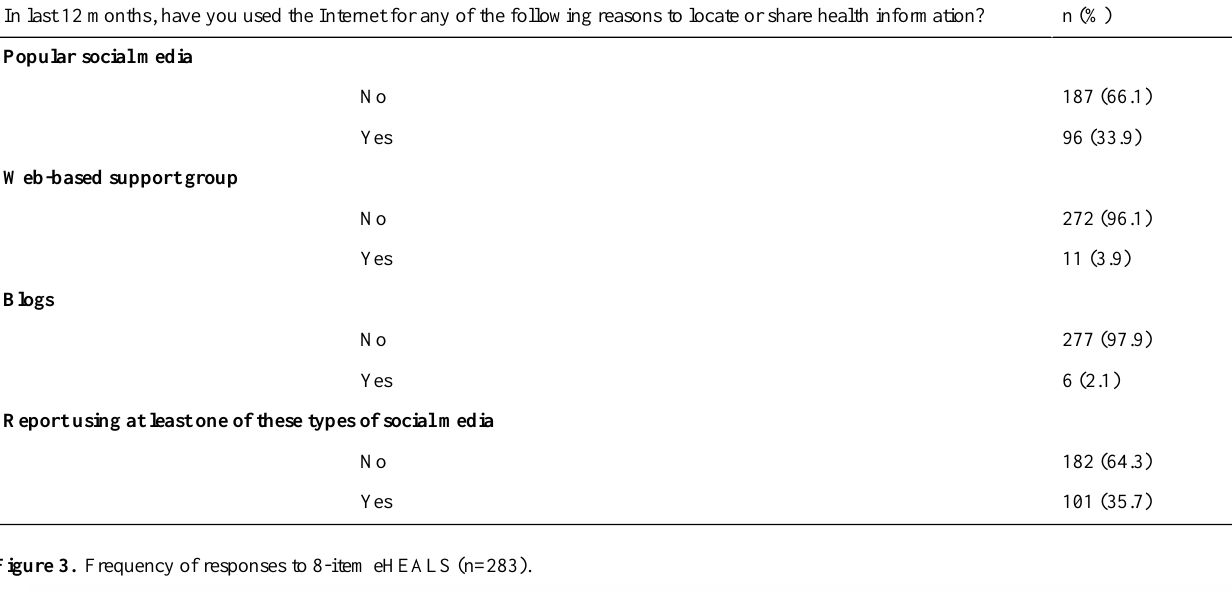
Table 2. Frequency and percentage of baby boomers and older adults who used Web 2.0 to locate or share health information (n=283).